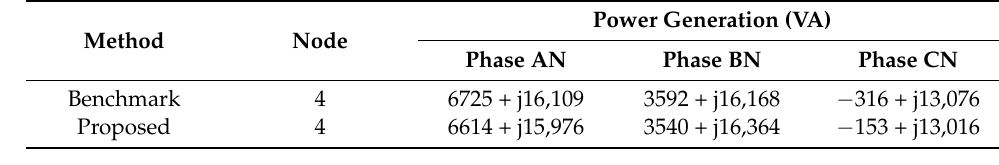
Table 5. Power generation at the PV node of benchmark and proposed methods.